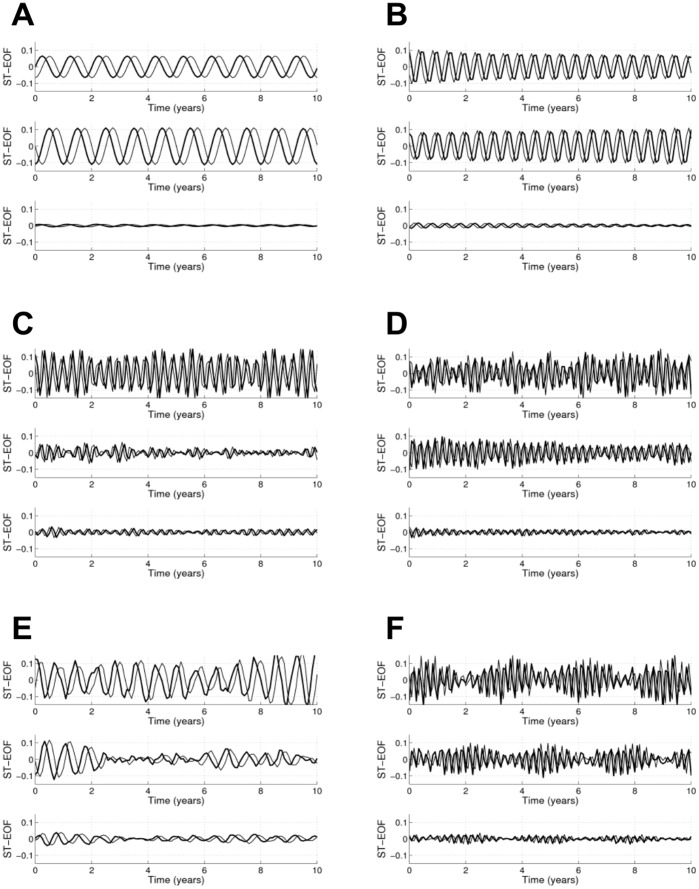
First six ST-EOFs pairs, with their associated resolved variance.The abscissa represents time (in months) and spans the window length M = 121 months. A: pair 1–2; B: pair 3–4; C: pair 5–6; D; pair 7–8; E: pair 9–10; F: pair 11–12.